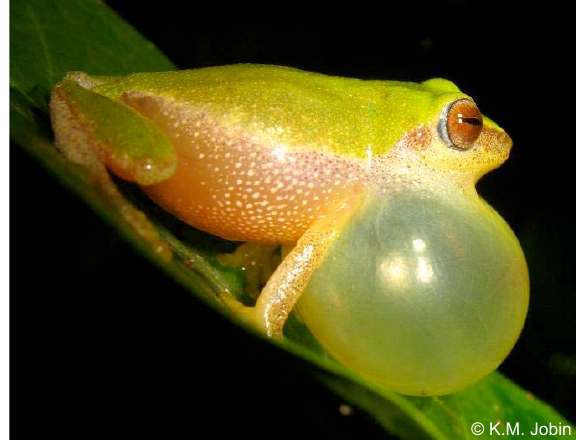
extending to the lower arm of forelimb leaving the upper arm white. Snout pointed, tympanum and supra tympanic fold not distinct. Lateral part of abdomen and limbs white or rarely with a sky blue tinge (Image